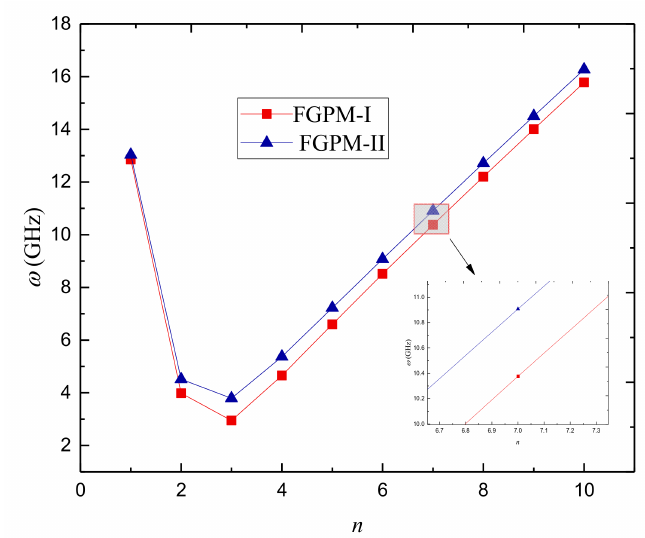
Figure 6. Variation of the natural frequency ω (GHz) against the circumferential wave number of different types of porous FGPM nanoshell.